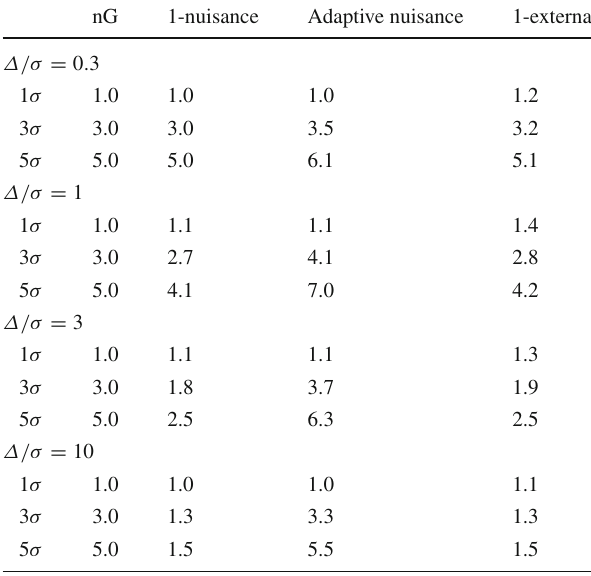
Table 2 Comparison of the size of one-dimensional confidence inter- vals at 1 , 3 , 5 σ for various methods and various values of Δ/σ